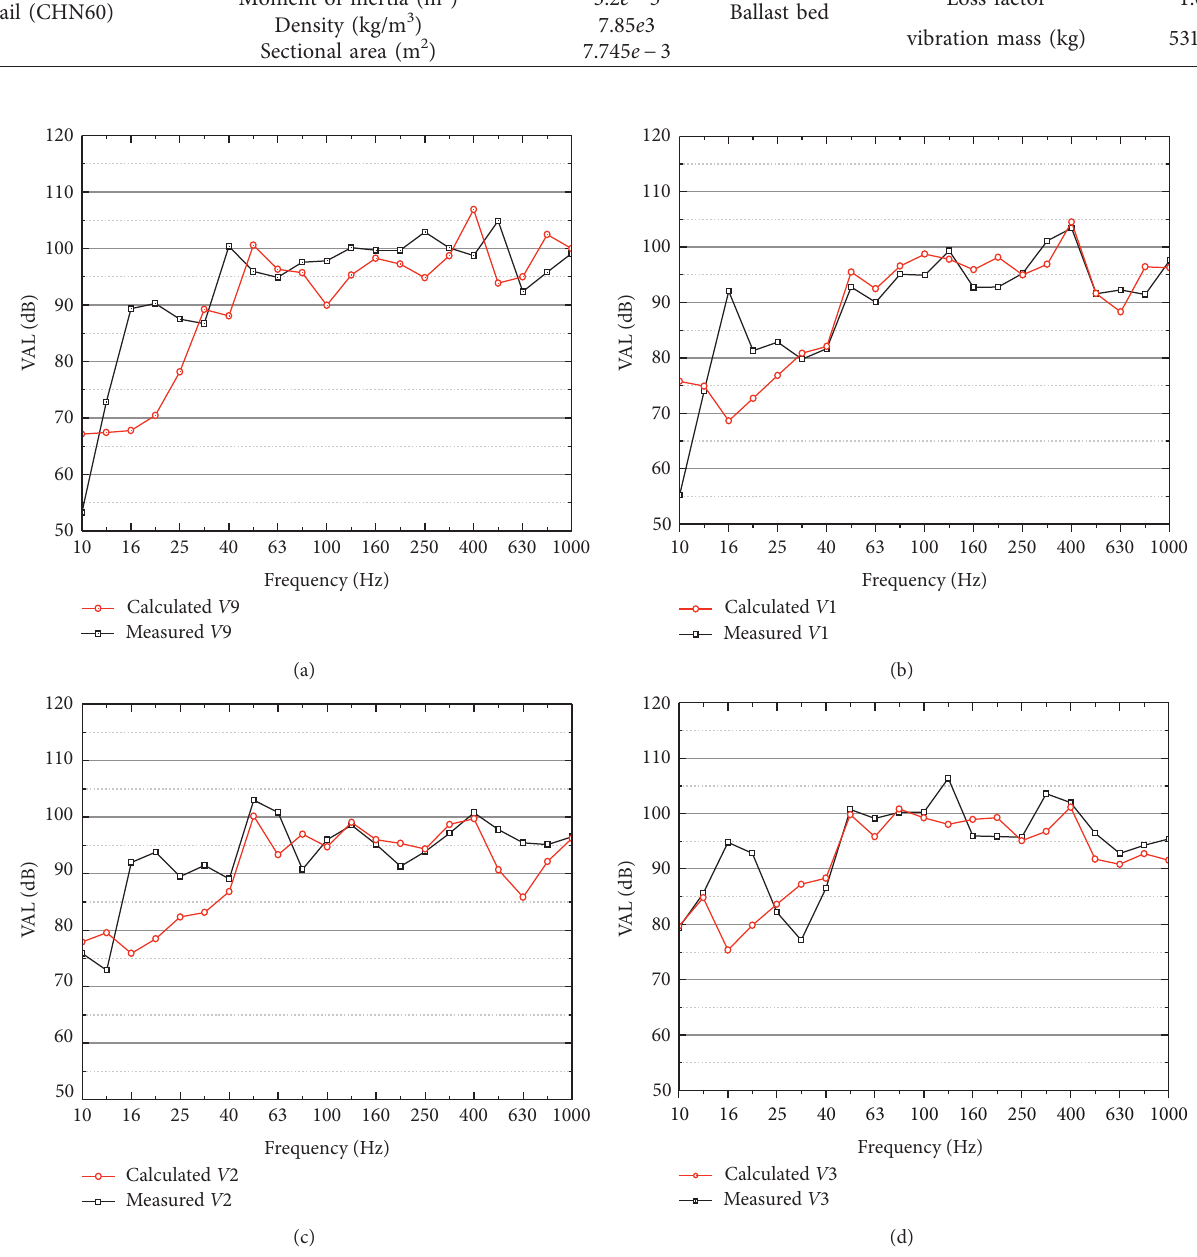
Figure 13: Comparison between test and numerical